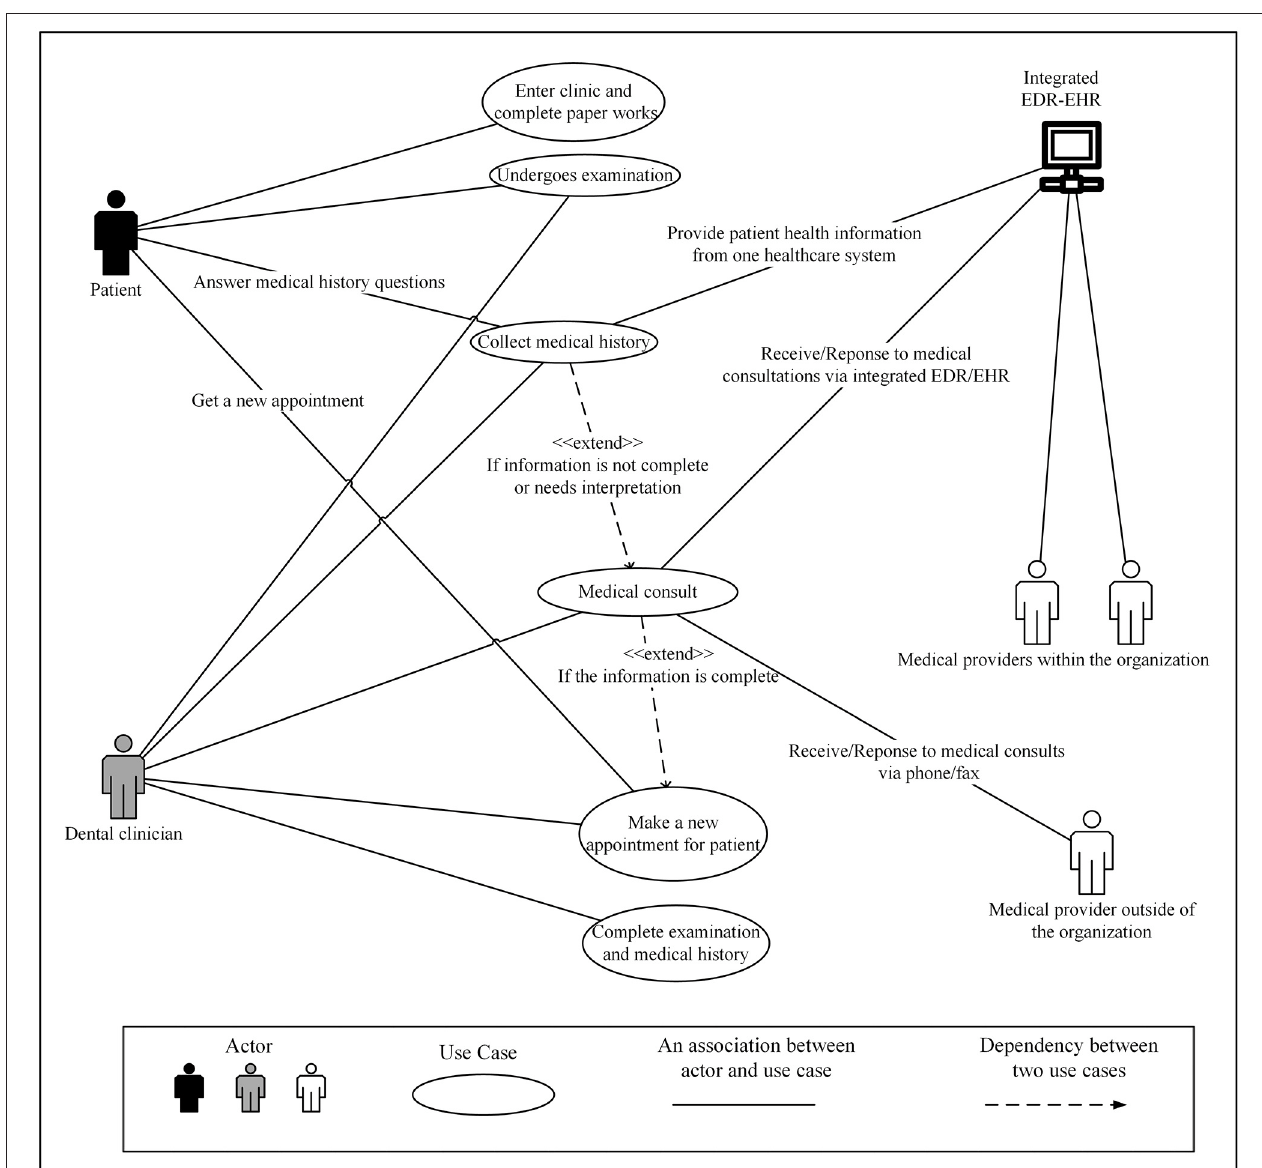
FIGURE 3 | Use Case Diagram for integrated electronic dental record-electronic health record (integrated EDR-EHR) approach as seen in a major healthcare organization (HCO) or federally qualified health center where dental and medical clinics are collocated or affiliated with the same HCO.